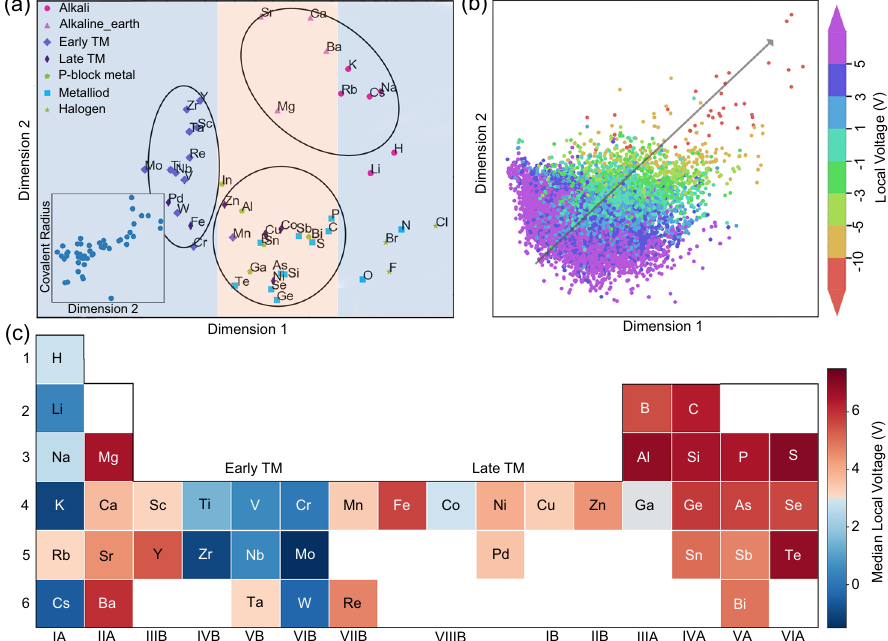
Fig. 3 Visualization of the DL model. a , b The visualization of the two principal dimensions with PCA for the element representations and the local oxygen-coordination-environment representations, respectively. Dimension 1 and 2 in the plot constitute a plane in the corresponding vector space that can approximate the representations best. The points in a are colored according to their elemental groups. c the median value of the learned local voltages for each element in the oxygen-coordination environments depicted in the elemental parodic table. The elements in b and c are labeled according to the type of center atoms in oxygen-coordination environments and the colors are coded with learned local voltages. The gray arrow in b indicates the change of local